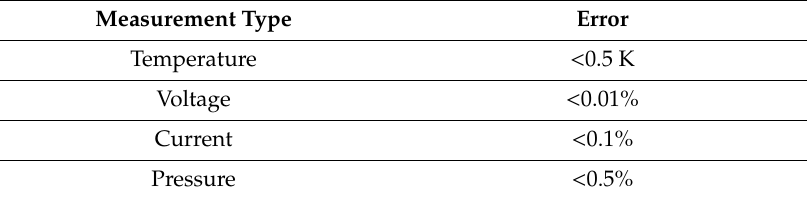
Table A1. Instrument bias